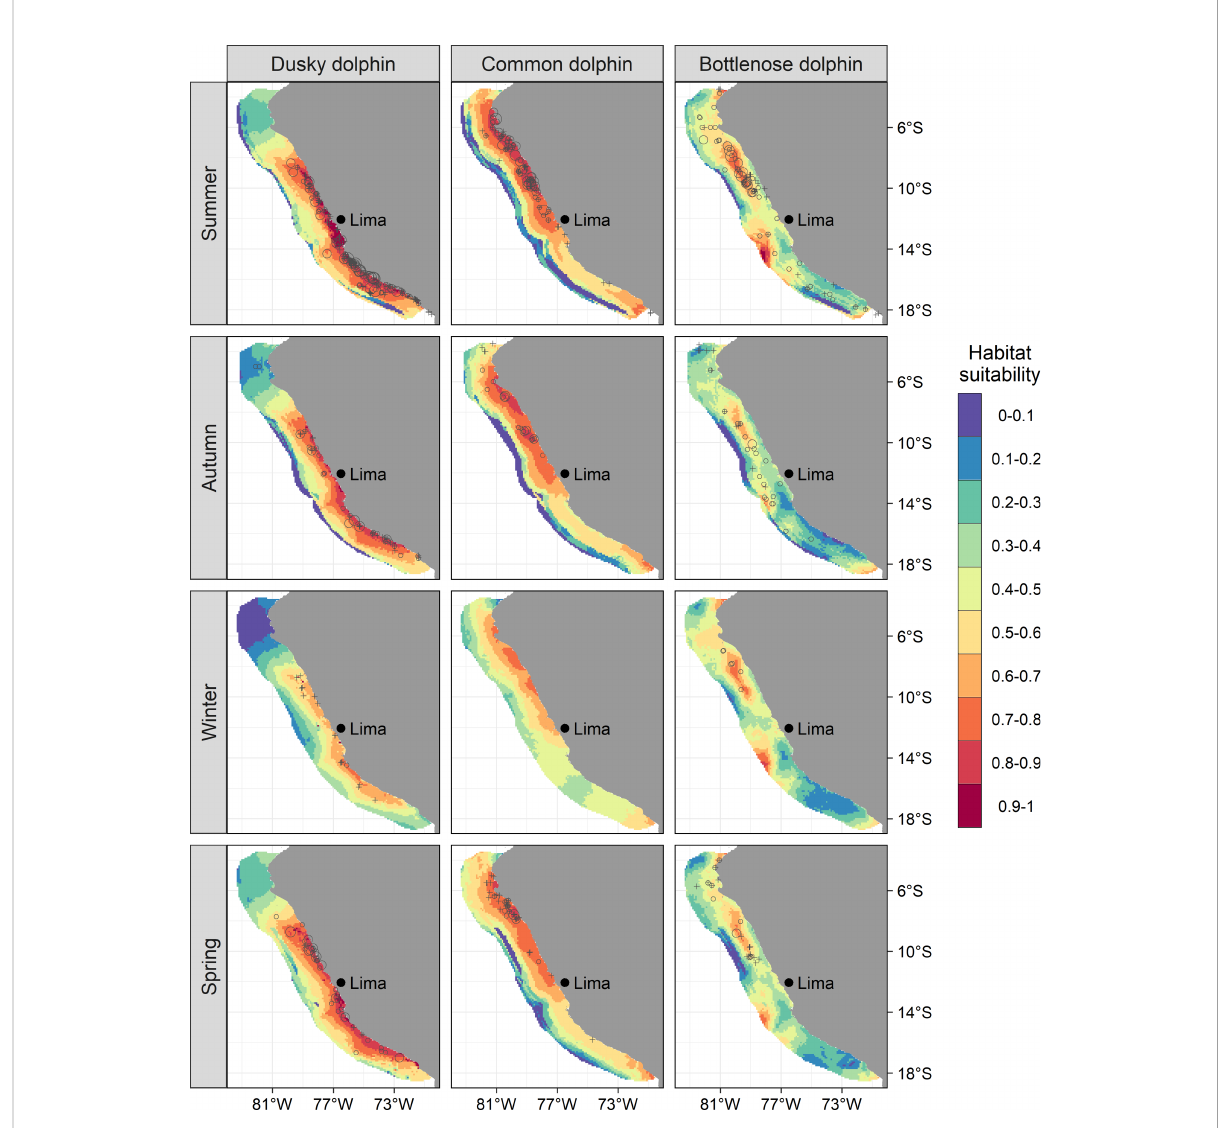
FIGURE 2 Predicted values habitat suitability of dolphin species in the northern Humboldt Current System for the geographical space. Empty circle sizes represent the observed group counts in each sample unit (i.e., transect). Crosses are validation data, not included in the model ’ s fi